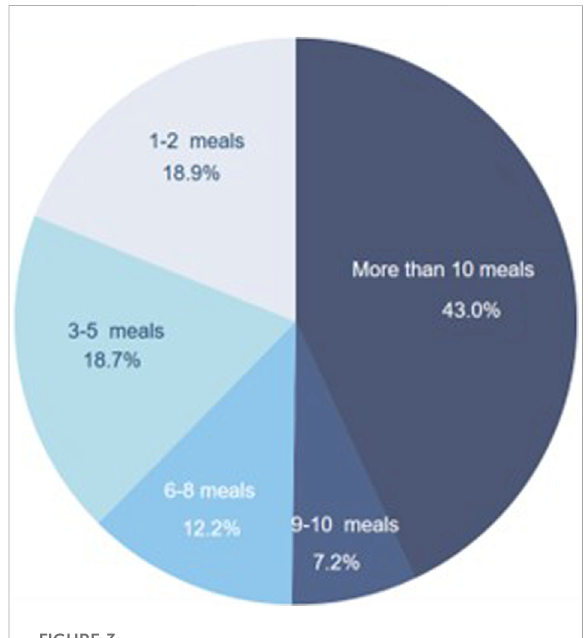
FIGURE 3 thedistributionofthenumberofmealsperweekinwhichthe respondents use